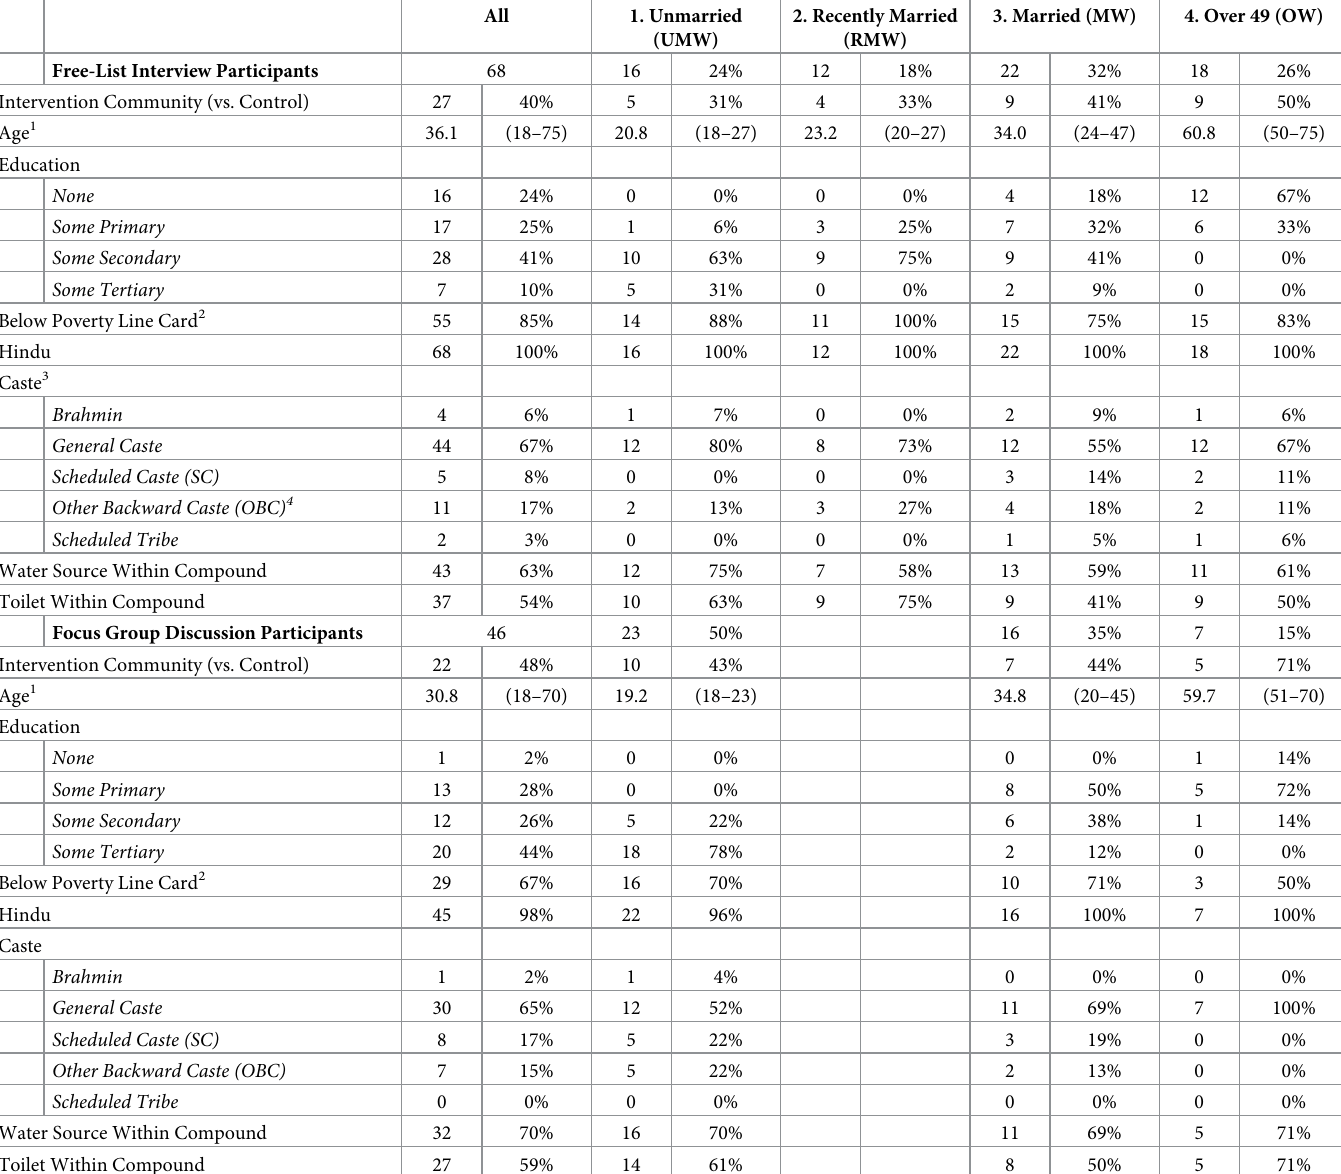
Table 1. Demographic information for participants in free-list interviews (N = 68) and focus group discussions (N = 46). All 1. Unmarried